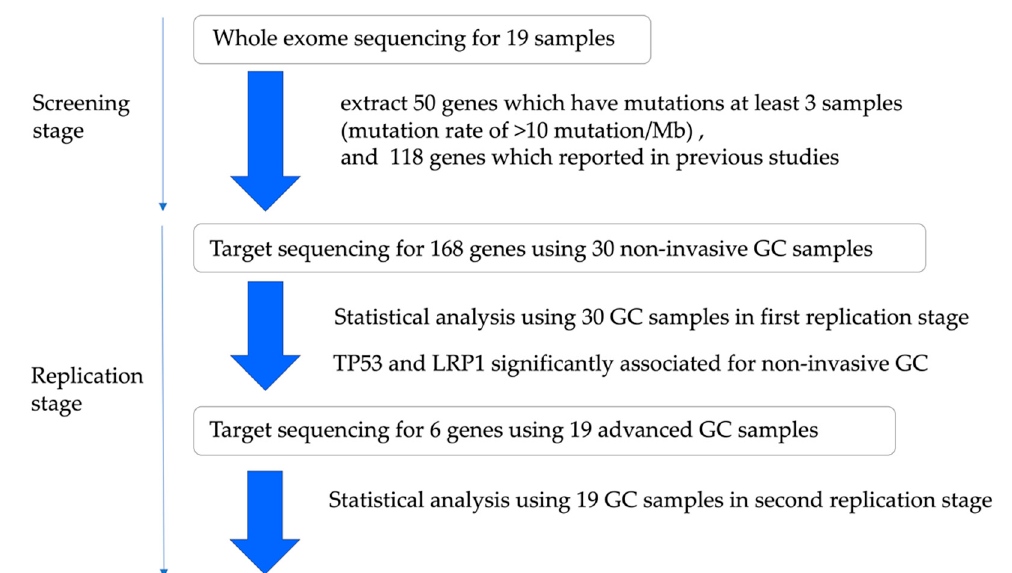
Figure 1. Outline of the study design. We performed whole-exome sequence of 30 non-invasive gastric cancer (GC cases) and, using Sanger sequencing, we were able to validate 19 cases. There were 50 genes which were mutated in more than three patients and had a mutation rate of > 10 mutation / Mb. As a replication study, deep sequence was performed in another 30 non-invasive GC cases for 168 genes, including the 50 genes and 118 previously reported gene mutations. Here, gene mutations of TP53 and LRP1 have been identified as significant in non-invasive cancer. In addition, deep sequence was performed in 19 advanced GC cases for six genes, including TP53 and LRP1.